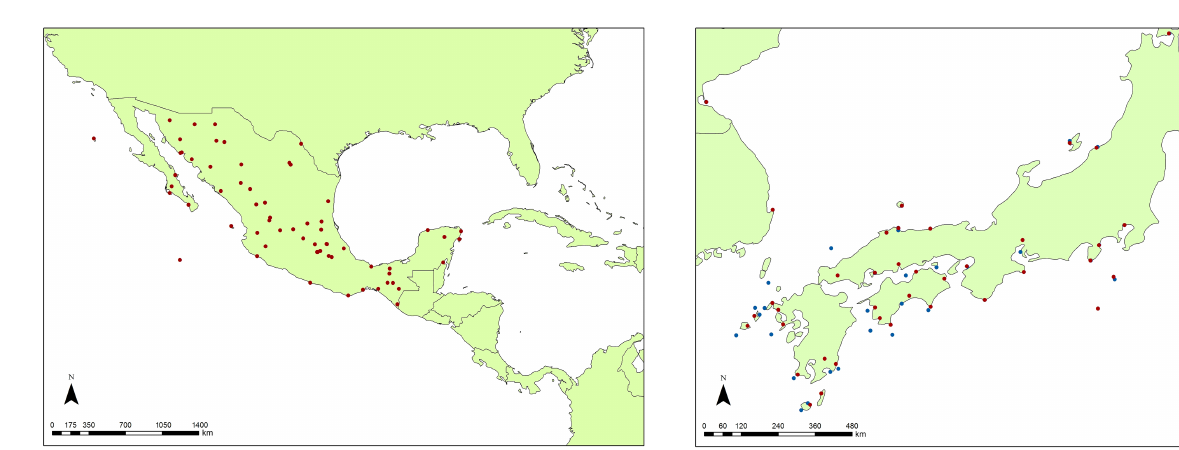
Figure 8. Map of the original station location situated in the ocean (blue dots) and the updated station location (red dots) for Japan.